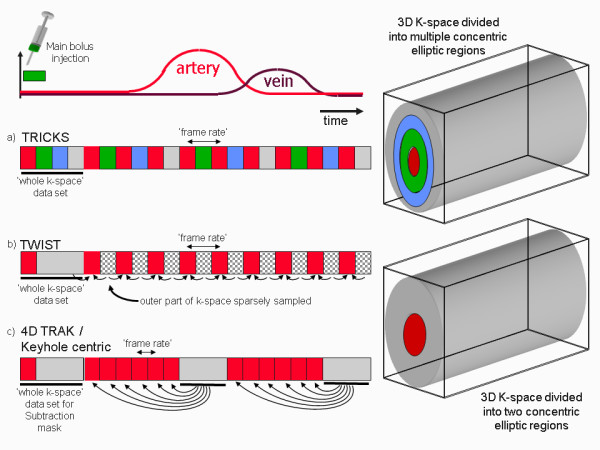
This diagram shows the time- resolved MRA approaches offered by three vendors. In each case, the effective frame rate is defined as the time interval between central zone acquisitions as this determines how often the image contrast is updated. In (a) the vendor implementation of time resolved imaging with contrast kinetics (TRICKS), divides 3D k-space into four elliptical concentric zones. Data is acquired initially for all four zones and subsequently the acquisition of the central zone is interleaved with each of the three outer zones in sequence. The solutions from two other vendors divide k-space into just two zones. In (b) the TWIST technique initially samples the whole of k-space and subsequently acquires the central zone interleaved with the outer zone. As the outer zone is much larger, although k-space lines are updated over the full extent of the outer zone, many lines are skipped. The missing lines are then updated in subsequent outer-zone acquisitions. In (c) the 4D-TRAK technique acquires the whole of k-space at the beginning, followed by between 4–6 consecutive acquisitions of the central zone, after which the outer zone of k-space is sampled once more. The initial whole k-space acquisition is used as a mask which is subtracted from later reconstructions to remove the background tissue signal. Subsequent outer zone acquisitions are combined with the preceding 6 central zone acquisitions (indicated by the curved arrows) to reconstruct time resolved image data sets.